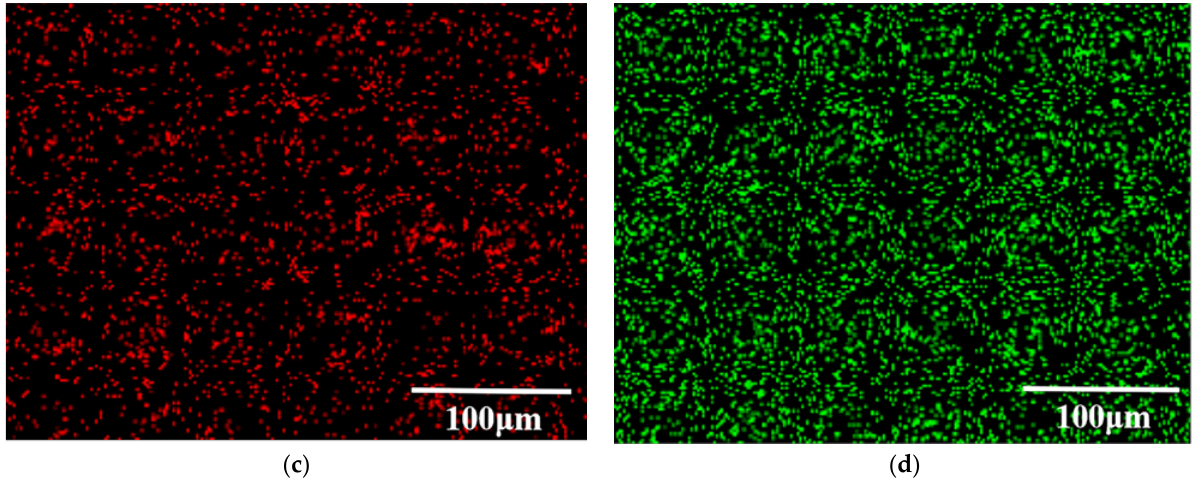
Figure 6. Surface element distribution of Al-20TiC-0.3G initial sample: ( a ) element distribution of Al; ( b ) element distribution of Ti; ( c ) element distribution of C; ( d ) element distribution of O.